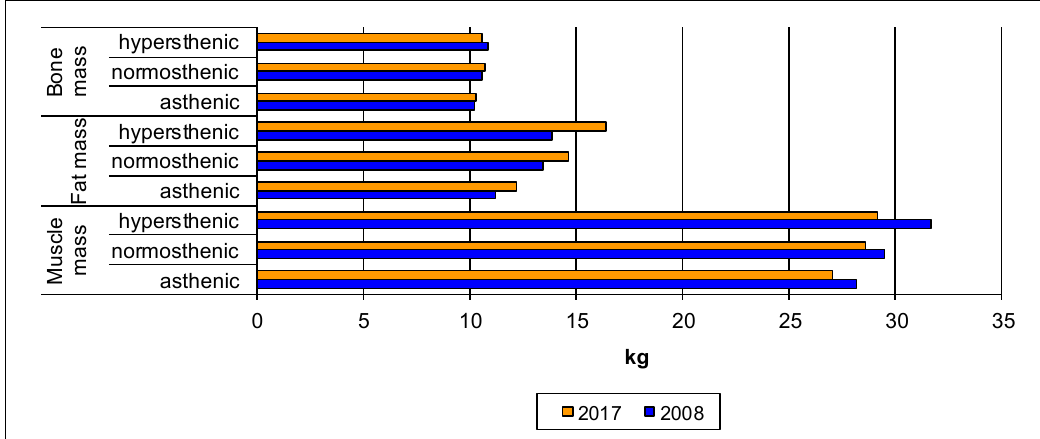
Fig. 2. The content of the main components in the body of young men of different generations and